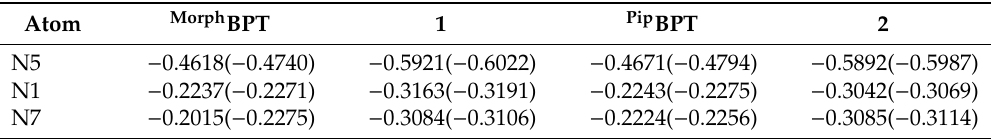
Table 7. The calculated natural charge at the N -sites of the free and coordinated pincer ligands using MPW1PW91(WB97XD) methods.